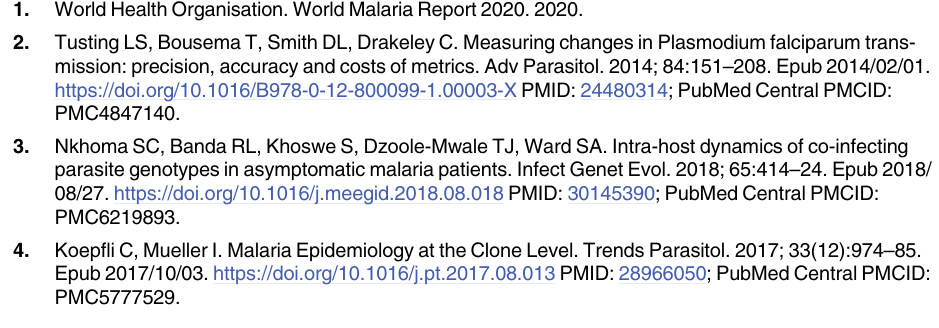
S1 Fig. PRISMA 2009 flow